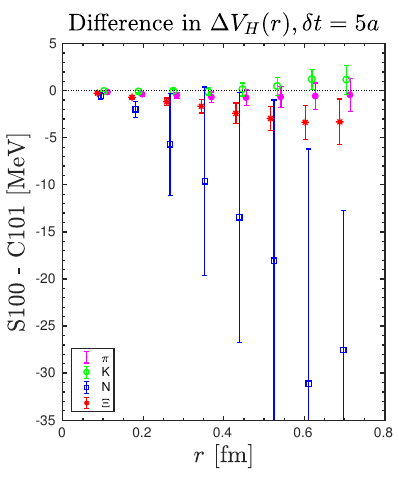
Figure 4. Volume study of the shift of the static potential ∆ V H in presence of various hadrons. We plot the di ff erence of the shifts between lattices of size L = 2 . 8fm (“S100”) and L = 4 . 1fm